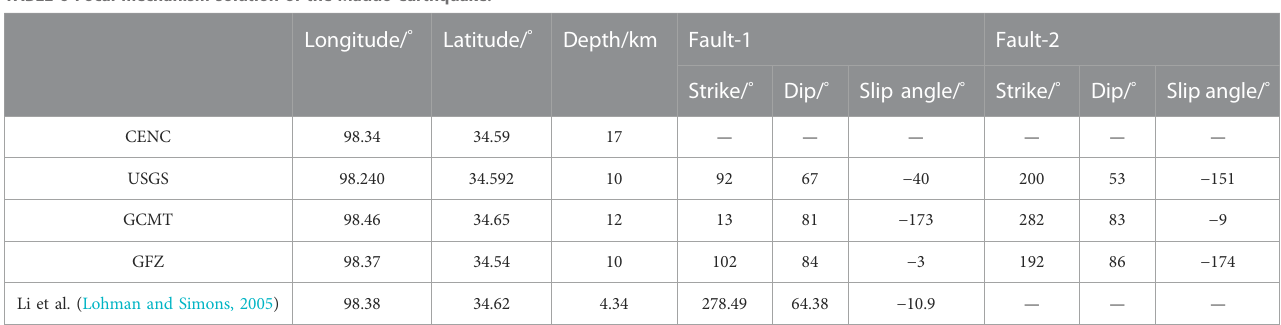
TABLE 6 Focal mechanism solution of the Maduo